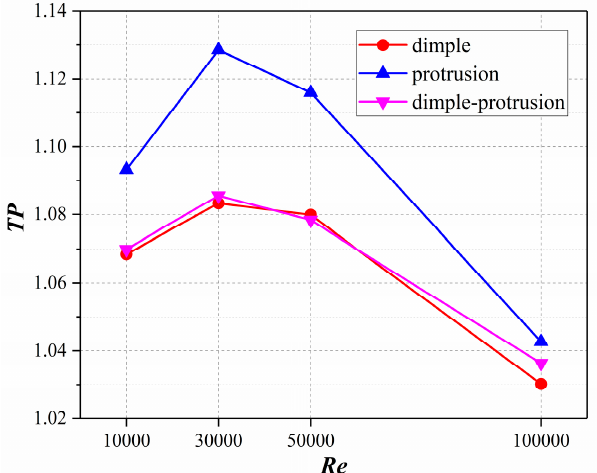
Figure 13. Variations of overall thermal performance with Re for different dimple/protrusion arrangements.